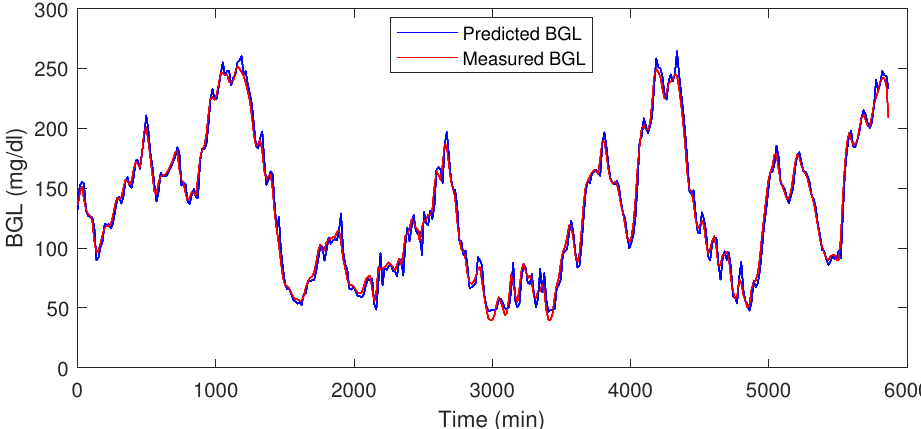
Figure 8. LSTM prediction result for